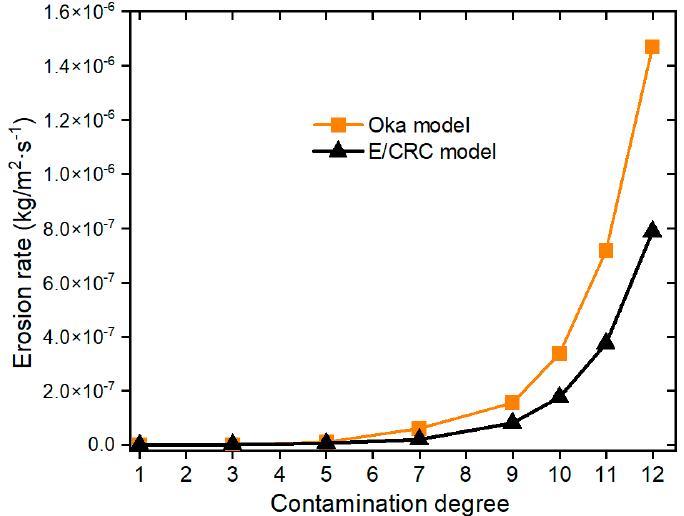
Figure 10. The erosion rates with different contamination degrees.